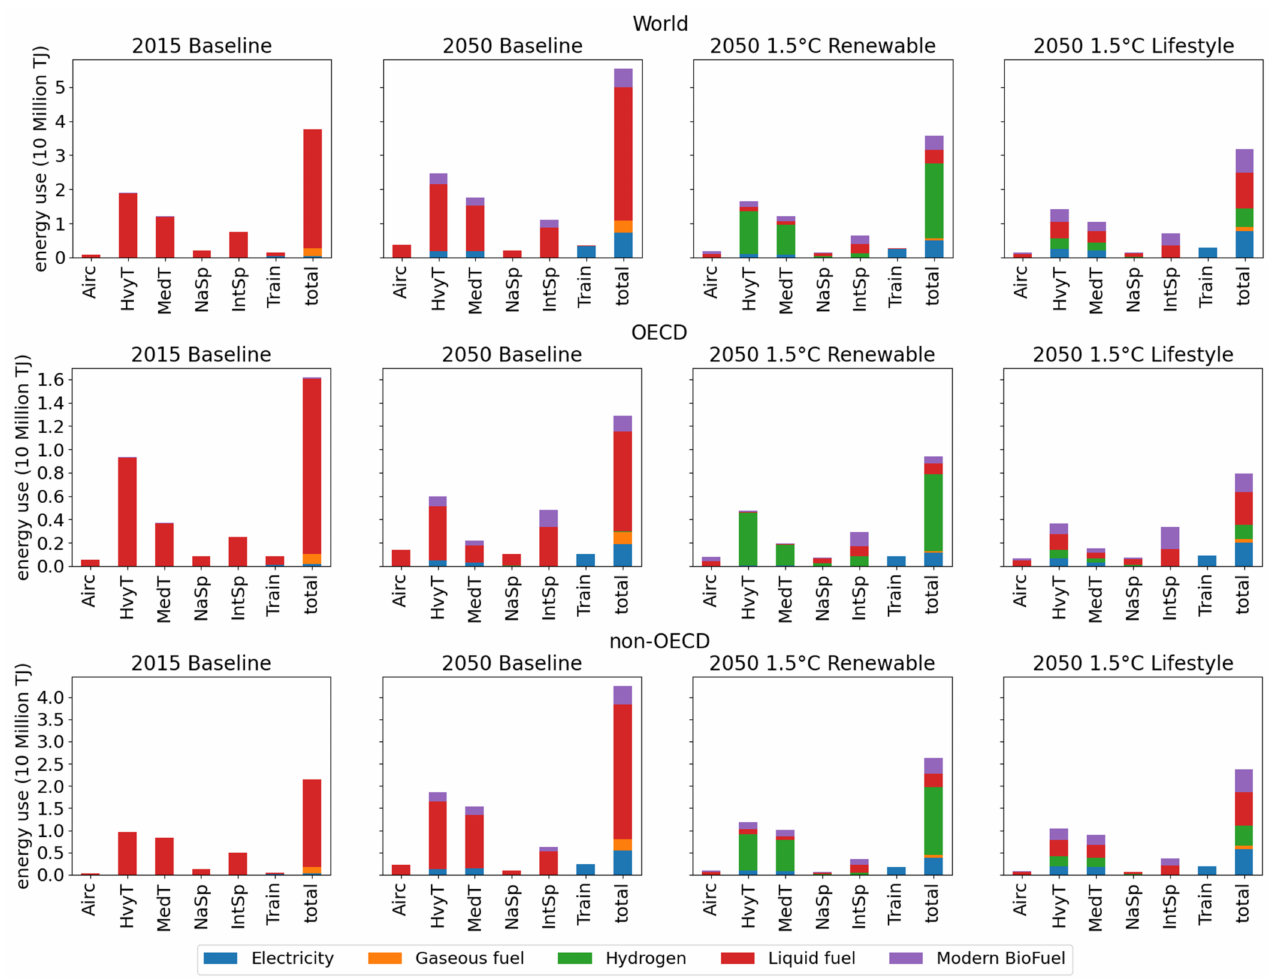
Figure 9. The energy mix of freight transport. Ship: national shipping, Train: freight train, MedT: medium truck, HvyT: heavy truck, Airc: air